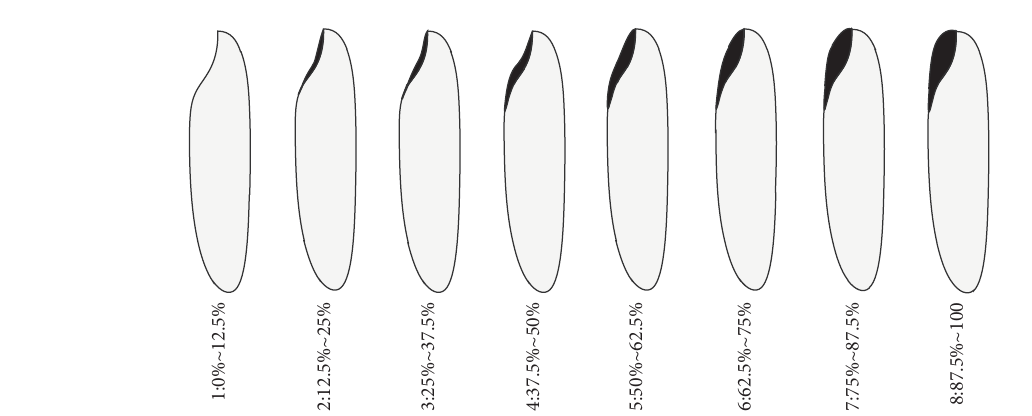
Figure 19: Rice germ integrity classification standard.